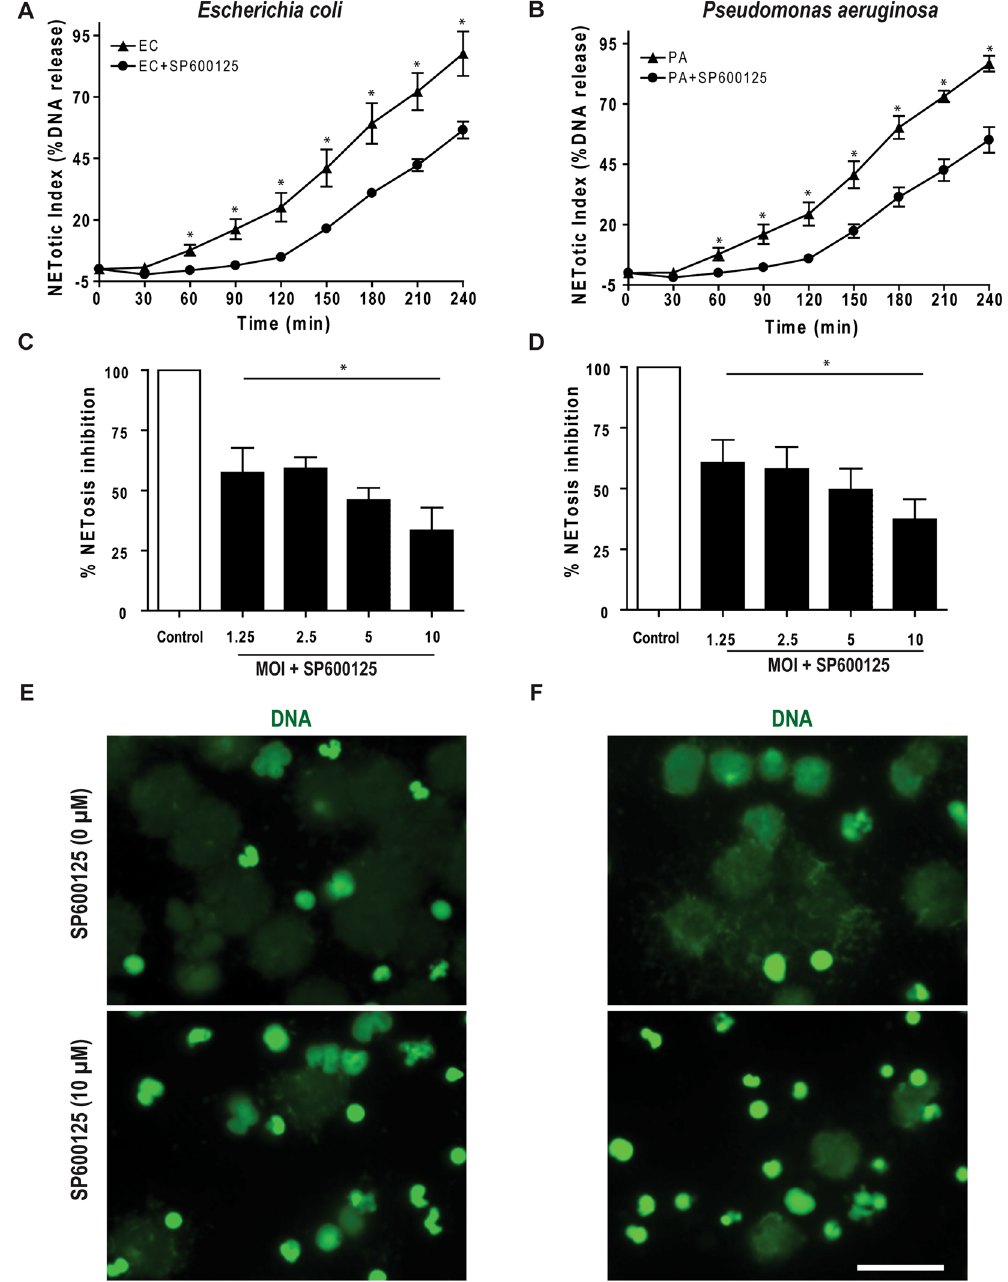
Figure 8. JNK inhibition suppresses both Escherichia coli- and Pseudomonas aeruginosa- mediated NETosis. ( A-B ) Sytox Green assays show the induction of NETosis by both E. coli (EC) and P. aeruginosa (PA; n = 3; * p value < 0.05; t-test). ( C–D ) Pretreatment of neutrophils with SP600125 and subsequent activation by E. coli and P. aeruginosa (0, 1.25, 2.5, 5.0, 10 MOI each), show significant increase in NETosis inhibition in each MOIs (n = 3; * p value < 0.05; One-way ANOVA with Dunnett’s post test). The NETosis induced by each bacterium in the absence of SP600125 was considered as 100%. Error bars in all the panels represent SEM. ( E–F ) Confocal images captured on the same day after completing the 4 hour NETosis assays, show clear NETs DNA (green) in E. coli and P. aeruginosa induced neutrophils along with NETosis inhibition in case of SP600125 pretreated conditions (n = 3; scale bar 25 μ